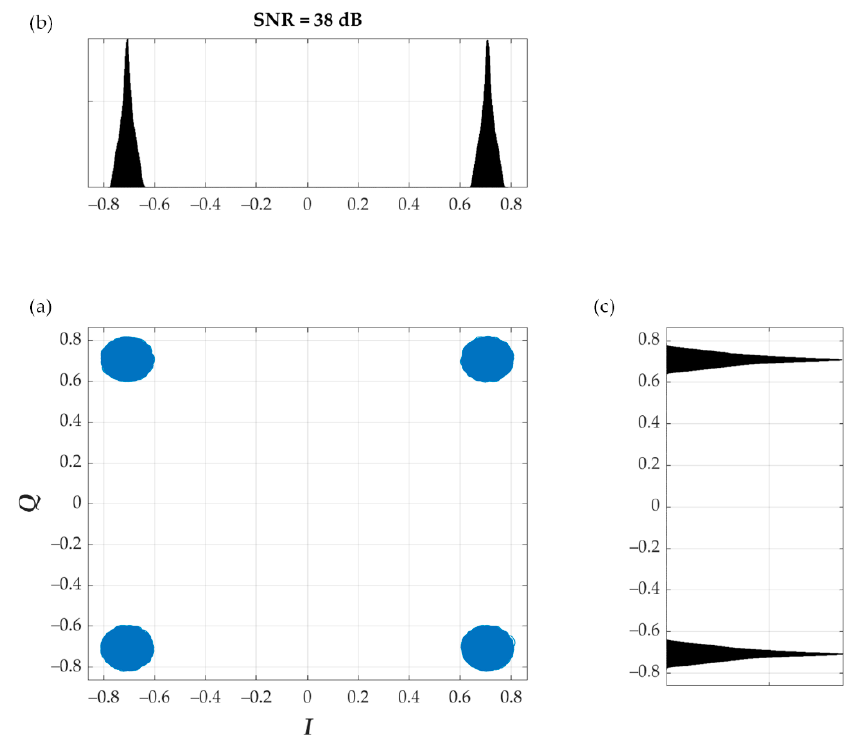
Figure 16. ( a ) Constellation, ( b ) in-phase and ( c ) quadrature histogram for SNR = 38 dB, K = 30, random A m , and EVM = 3%.